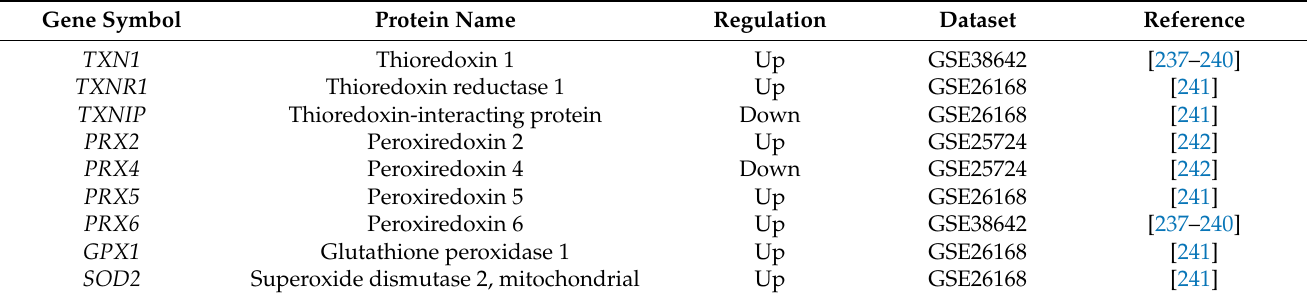
Table 1. Dysregulated genes of redox-regulating proteins in type 2 diabetes mellitus (T2D) patients. Gene